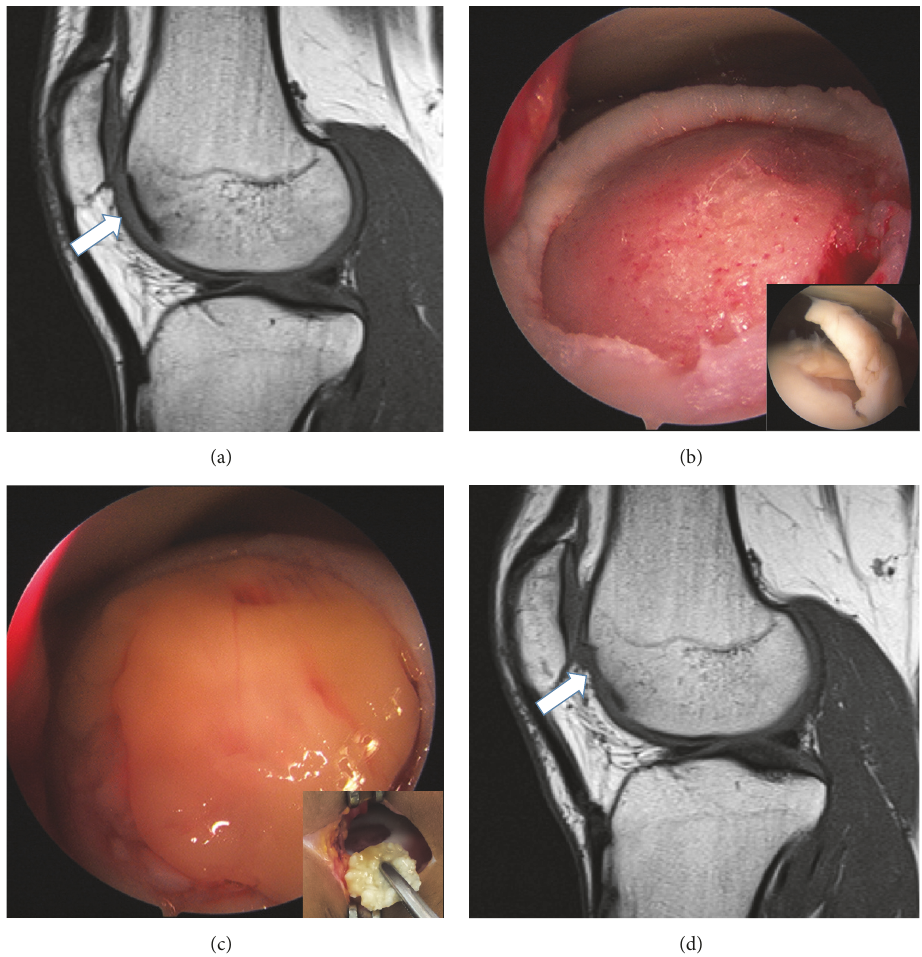
Figure 3: Composition of figures demonstrating the initial injury, surgical treatment, and postoperative MRI 6 months after surgery. (a) Preoperative sagittal T1-sequence MRI demonstrating an osteochondral injury (white arrow). (b) Intraoperative picture demonstrating the debrided defect in the lateral femoral condyle. The small picture shows the injury seen during the diagnostic arthroscopy. (c) Intraoperative picture demonstrating the filled defect after the autologous matrix had been applied. (d) Postoperative sagittal T1-sequence MRI demonstrating adequate filling and incorporation of the matrix in the lateral femoral condyle and absence of subchondral oedema (white